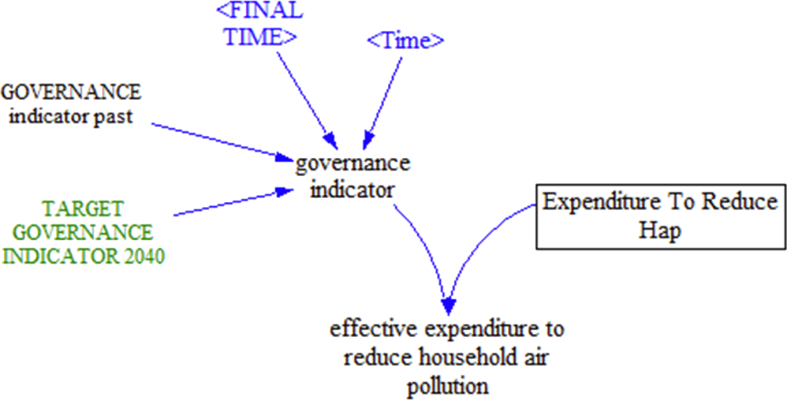
Formulation of good governance and effective expenditure.